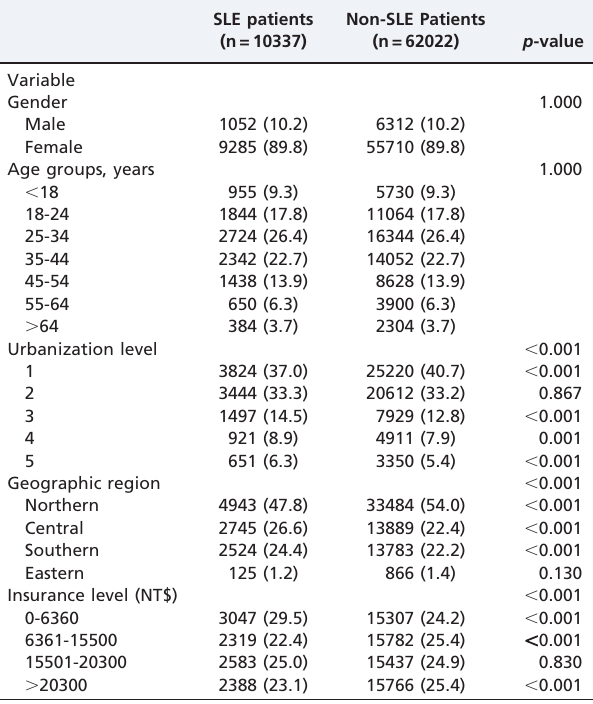
Table 1 - Demographic data of patients with systemic lupus erythematosus (SLE) and of the control cohort. SLE patients Non-SLE Patients (n=10337) (n=62022) p